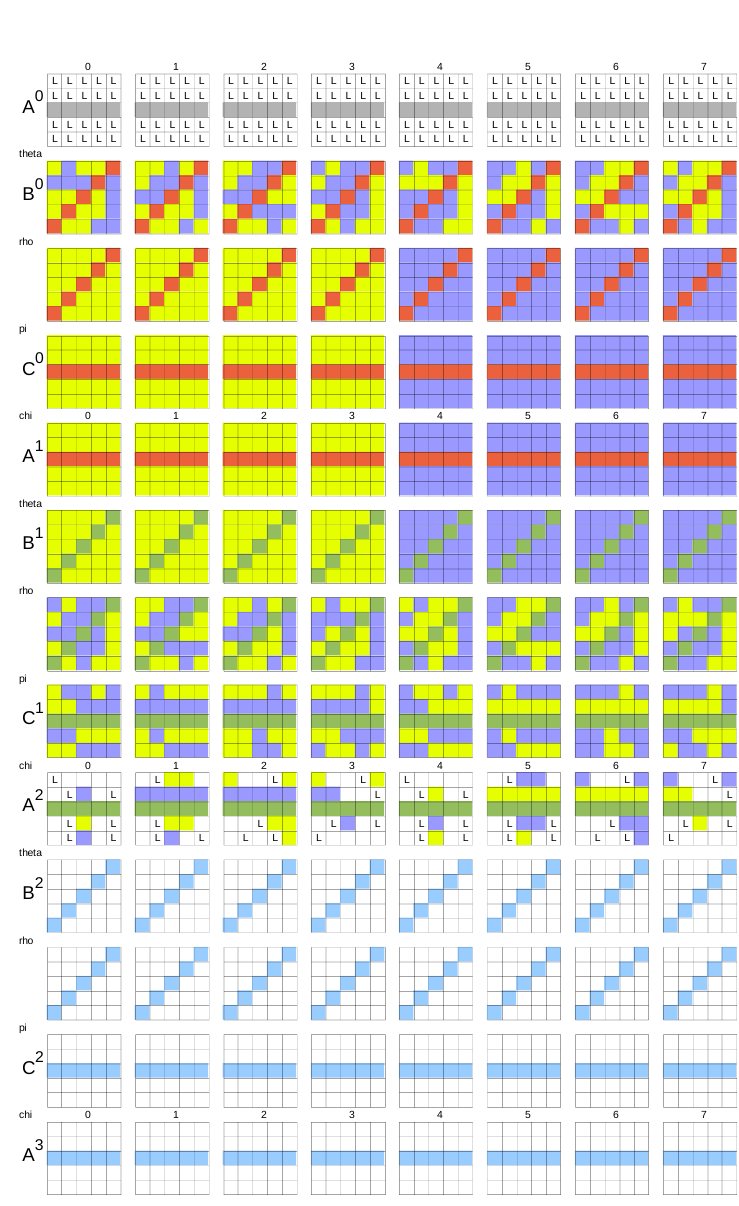
Figure 10: Representation of the 3-round attack. Each 5 × 5 square represents a slice, each small square is a bit, and each line of squares represents the full state (the 8 slices) at a certain instant. The first state that outputs a value is the one on the top, and the last the one at the bottom. The bits colored in grey, green, red and blue are known bits from the outputs. The bits colored in yellow are known bits from A u ( L 1 ). Colored bits in purple are known bits from A v ( L 2 ). Bits with an L represent bits that can be computed as a linear combination of bits from values obtained from A u and from A v . The ones in white represent a quadratic combination of both